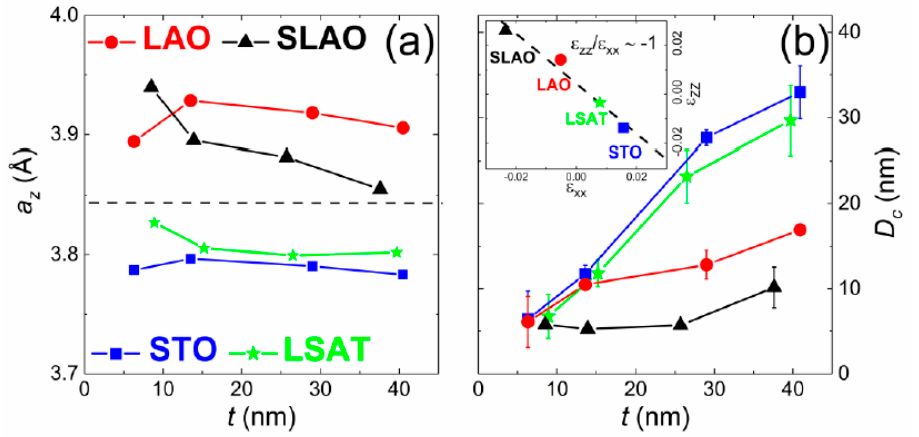
Figure 3. Thickness and substrate-induced strain dependencies of lattice parameter ( a ) and esti- mated crystal size ( b ) in the z-direction of LSCO films grown on STO, LSAT, LAO, and SLAO substrates. The dashed line in ( a ) indicates the lattice parameter value of LSCO bulk (3.84 Å). Inset shows out-of-plane lattice strain versus in-plane lattice strain, with a linear fit presented by the dashed line (see text).